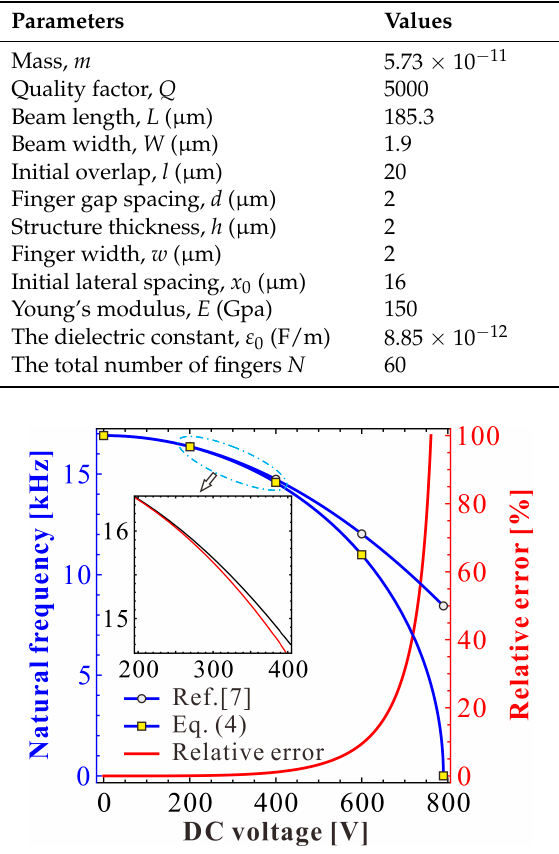
Table 1. Geometric and material parameters of a MEMS resonator (refer to Reference [7]).